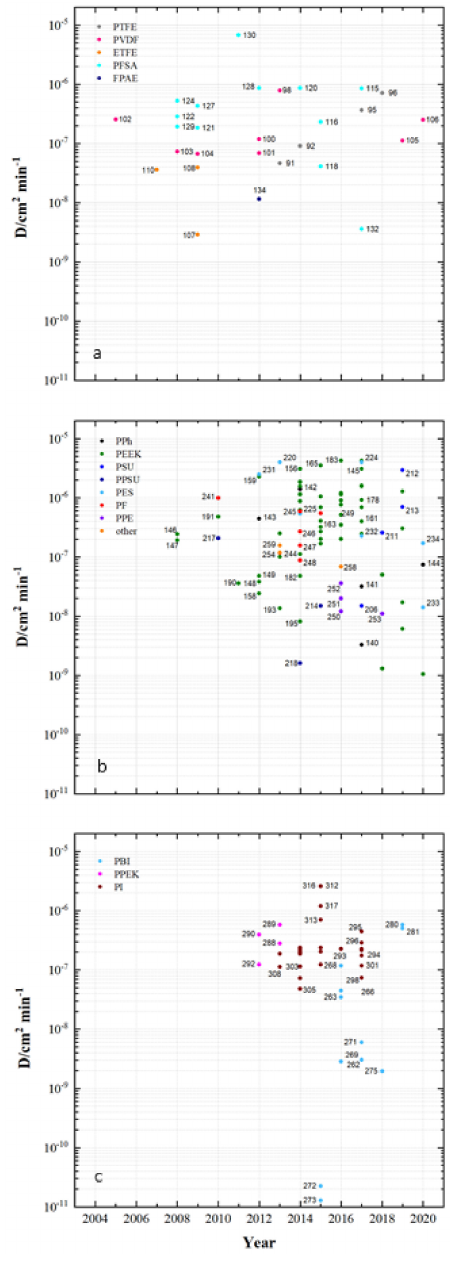
Figure 8. Measured diffusion coefficients of tested polymer membranes in recent years: ( a ) fluoro- carbons, ( b ) hydro-carbons and ( c ) N